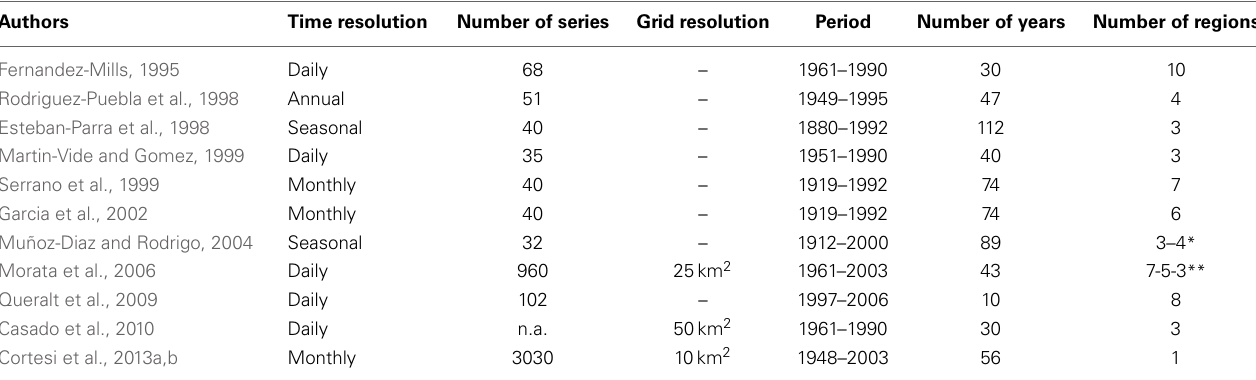
Table 1 | Examples of regionalization of precipitation in the